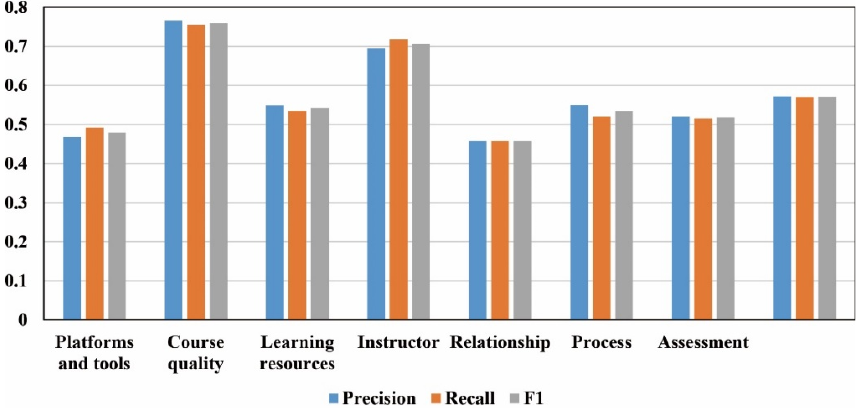
Figure 3. Performance of RCNN based on precision, recall, and F1-score.